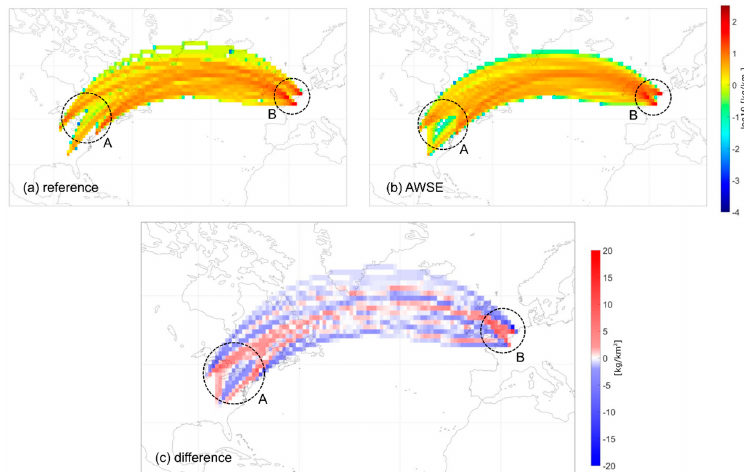
Figure 9. Inventories for fuel consumption for the NAT study and the FXD setting combined for leader and follower. Reference scenario ( a ), AWSE scenario ( b ); Inventory for difference in fuel consumption for the NAT study and the FXD setting ( c ). Note: the rasterization effect is due to the cell size of the inventories.